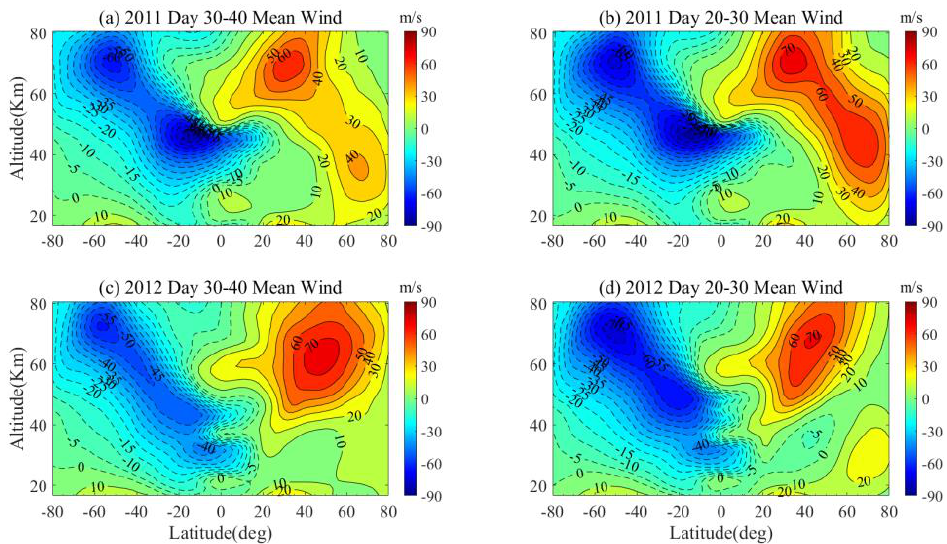
Figure 7. MERRA − 2 mean zonal winds during days 30 − 40 and 20 − 30 in 2011 and 2012. The contour intervals are 10 m/s. The vertical dot lines are the same as in Figure 2. The bold red (yellow) line is the critical level of W4 (W3) where the mean zonal wind matches the wave phase speed. The dotted line represents the easterly wind. The solid line represents the westerly wind.